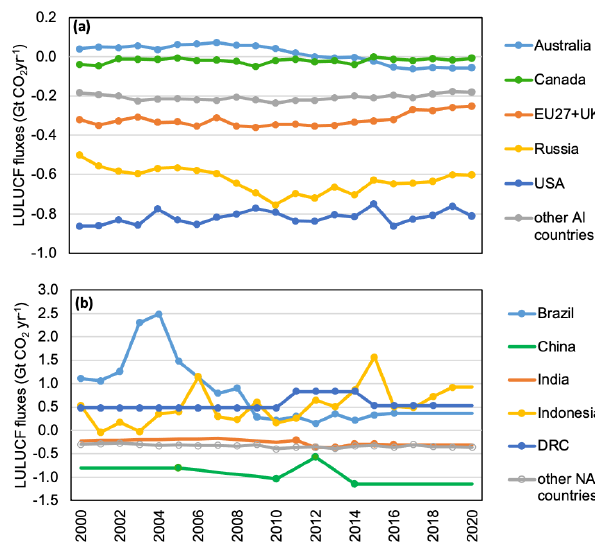
Figure 3. Trends 2000–2020 of LULUCF CO 2 fluxes from the NGHGI DB for the largest Annex I (a) and non-Annex I (b) coun- tries (or country aggregations). Dots indicate the years for which the data exist in the original submission (i.e. not gap